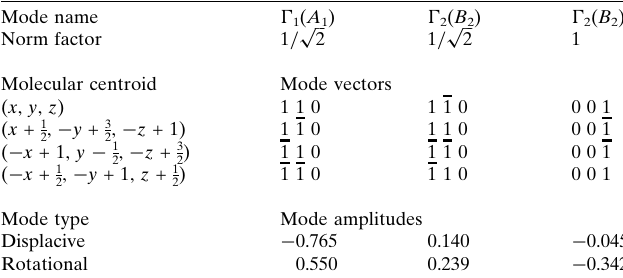
Table 5 Displacive (A˚ ) and rotational (radians) symmetry-modes and amplitudes for the phase III ! II transition. Divide by 2 to obtain corresponding molecular translation distances and rotation angles (see Section 2.9). The first mode vector corresponds to the molecule with the centroid near [0.37, 0.62, 0.625] in the unstrained child cell.